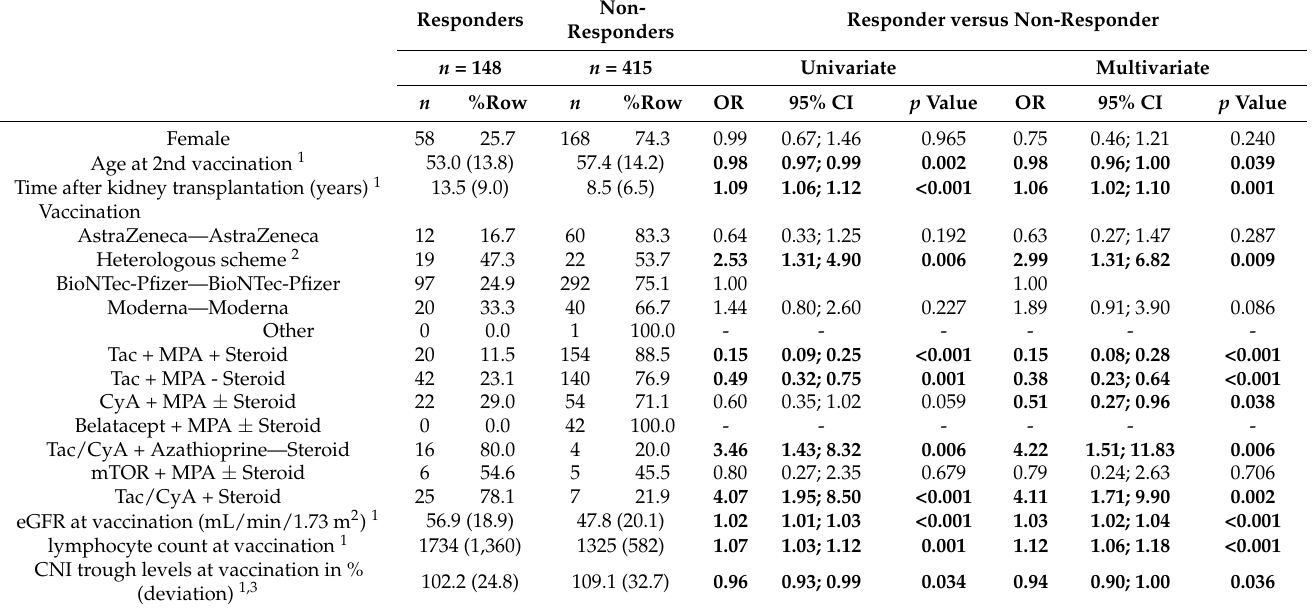
Table 2. Univariate and multivariate analysis of factors associated with serological response to SARS-CoV-2 vaccination after kidney transplantation.